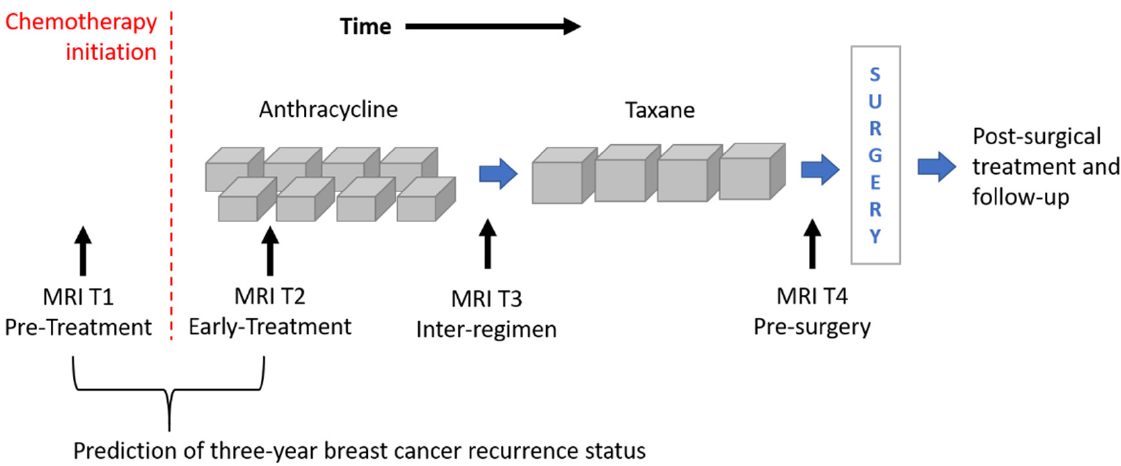
Figure 1. Outline of the MRI exams acquired for patients of the I-SPY1 TRIAL dataset undergoing neoadjuvant chemotherapy. MRIs related to timepoints T1 and T2 were analyzed for the prediction of three-year breast cancer recurrence.